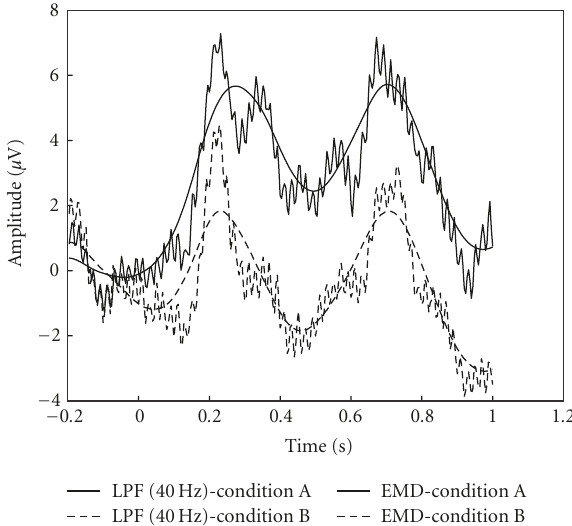
Figure 6: EMD-denoised averages for conditions A and B are superimposed onto corresponding averages of trials lowpass filtered at 40Hz. Threshold frequency is 3Hz, calculated according to the criteria in (13).